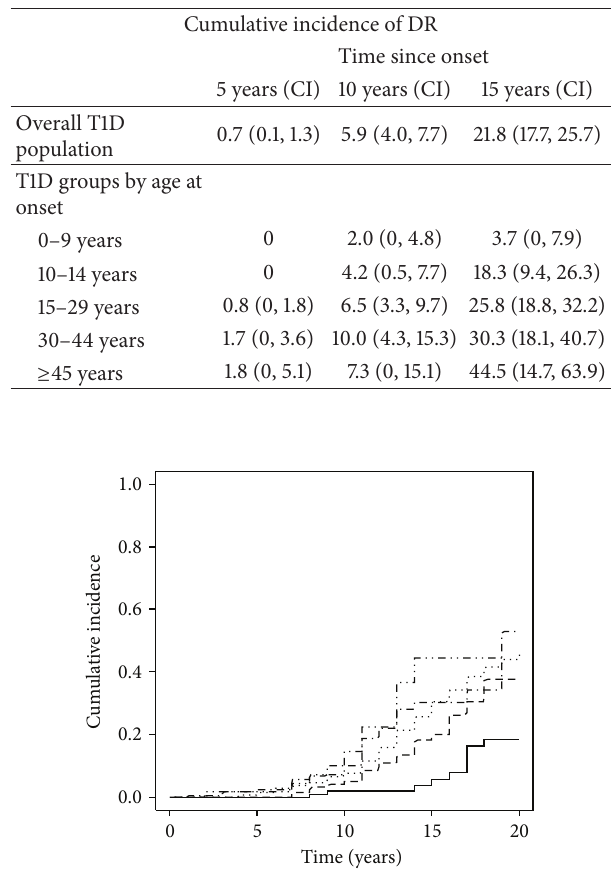
Table 1: Demographic and clinical characteristics at onset of our population of T1D patients.